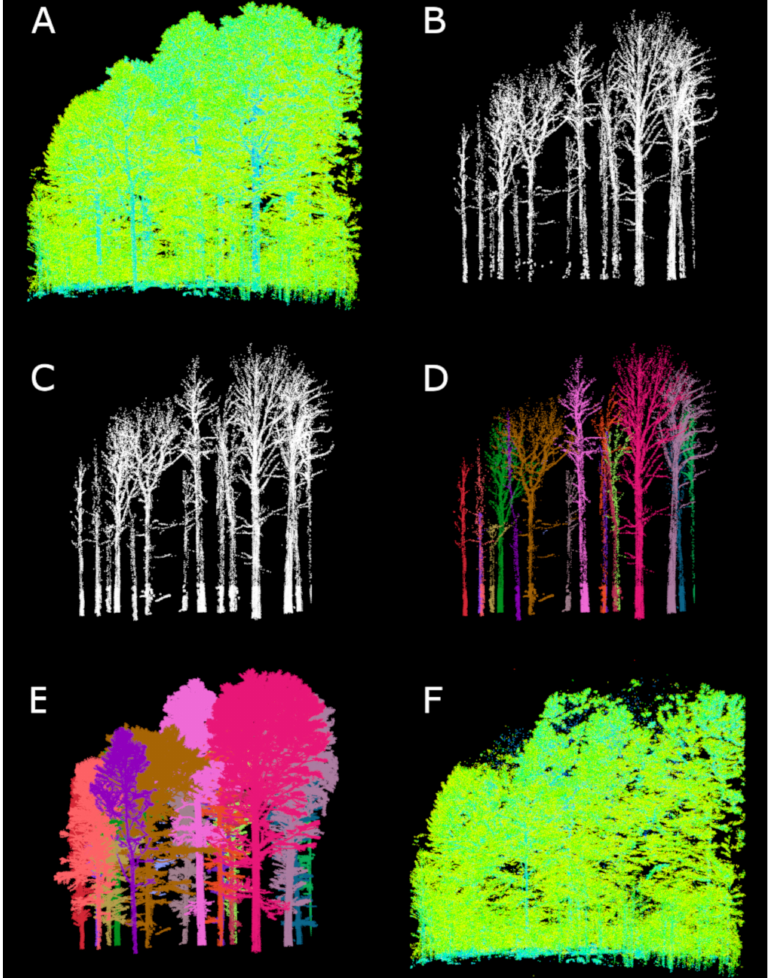
Figure 2. Lateral view of a 20 m × 20 m section of ultra-high-density drone lidar in a temperate mountain forest in the south Bohemia region of the Czech Republic: ( A ) The vegetation point cloud; ( B ) Skeleton points after low-intensity filtering; ( C ) Skeleton points + stem base points after spatial filtering and before segmentation; ( D ) Segmented skeletons I + II.; ( E ) Segmented trees after proximity point assignment; ( F ) Undi ff erentiated